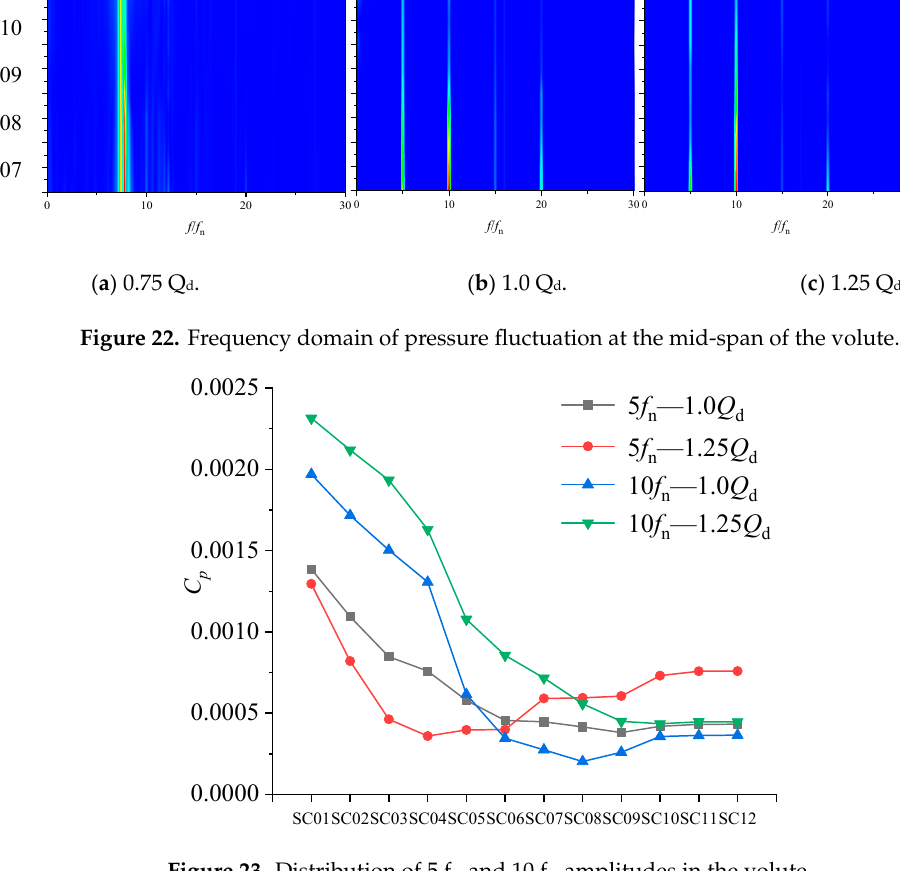
Figure 23. Distribution of 5 f n and 10 f n amplitudes in the